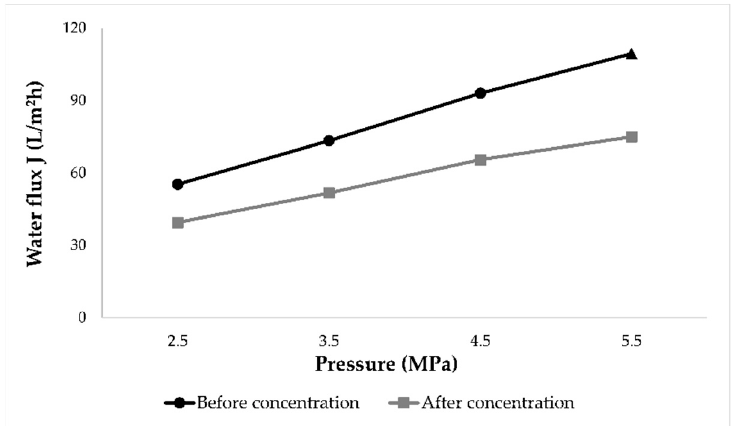
Figure 4. Water fluxes (L/m 2 h) before and after nanofiltration of conventional and ecological Cabernet Sauvignon wine measured on 2.5, 3.5, 4.5 and 5.5 MPa at 25 ◦ C. Table 1. Fouling index (%) of nanofiltration membranes at four different pressures.